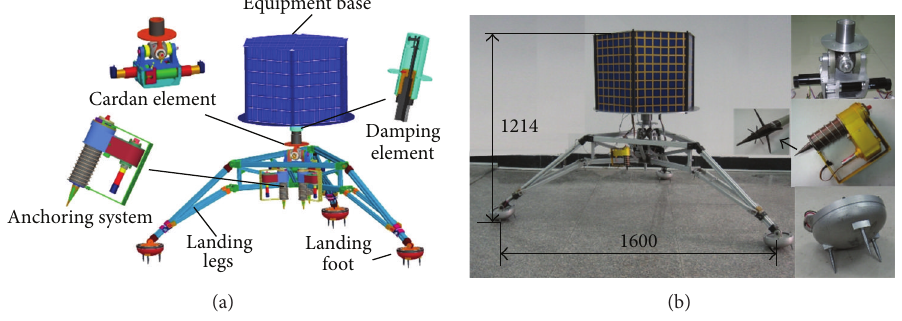
Figure 2: Pictures of the landing mechanism.